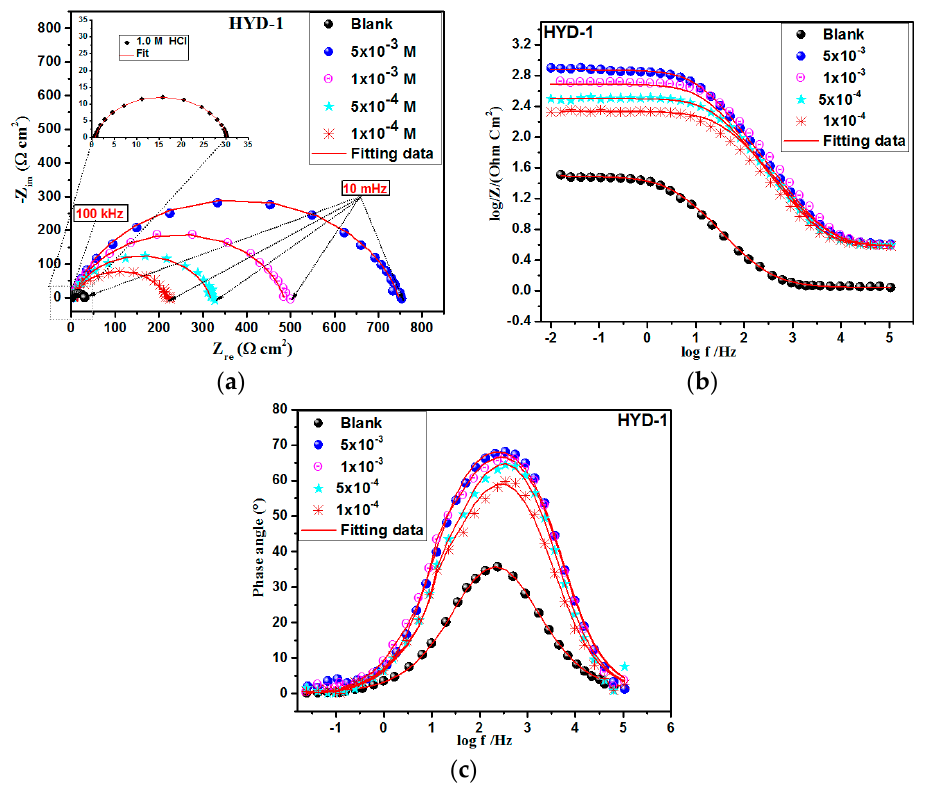
Figure 5. Nyquist ( a ), Bode ( b ), and phase angle ( c ) plots of mild steel in 1.0 M HCl with and without various concentrations of HYD-1 inhibitor.